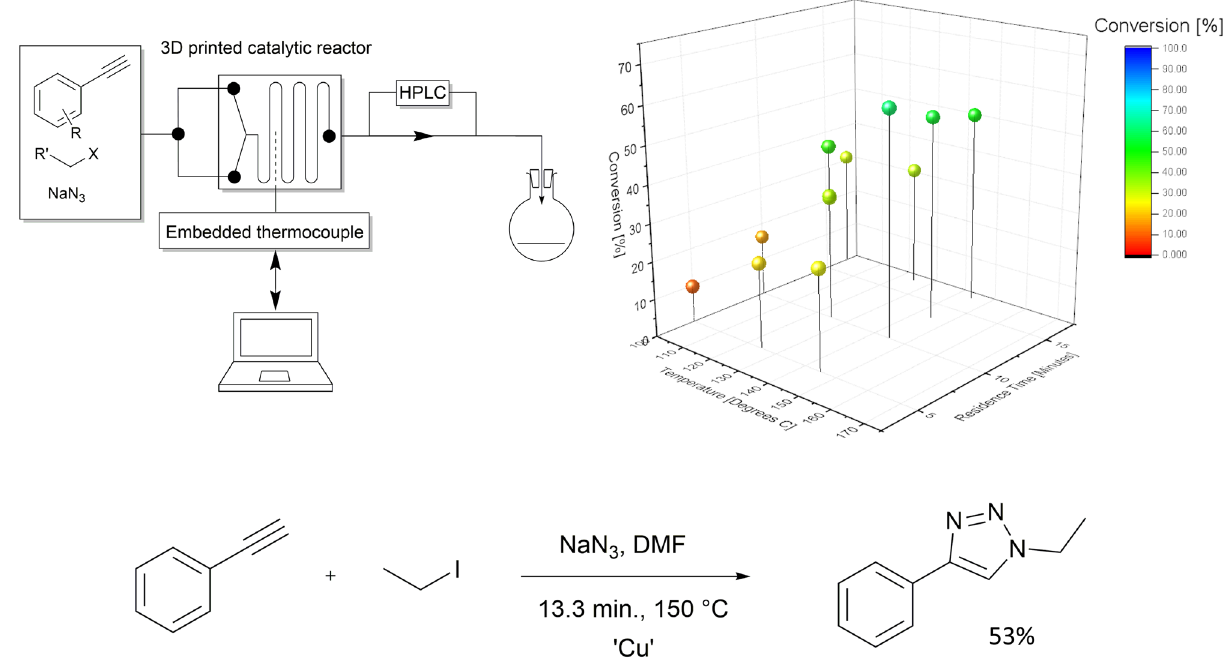
Figure 5. (Top left) schematic of setup used to incorporate 3DP reactor into flow system (top right) reaction conversions obtained during optimisation (bottom) scheme of Huisgen cycloaddition 57 between Phenylacetylene and Iodoethane used in optimisation and displaying the optimised